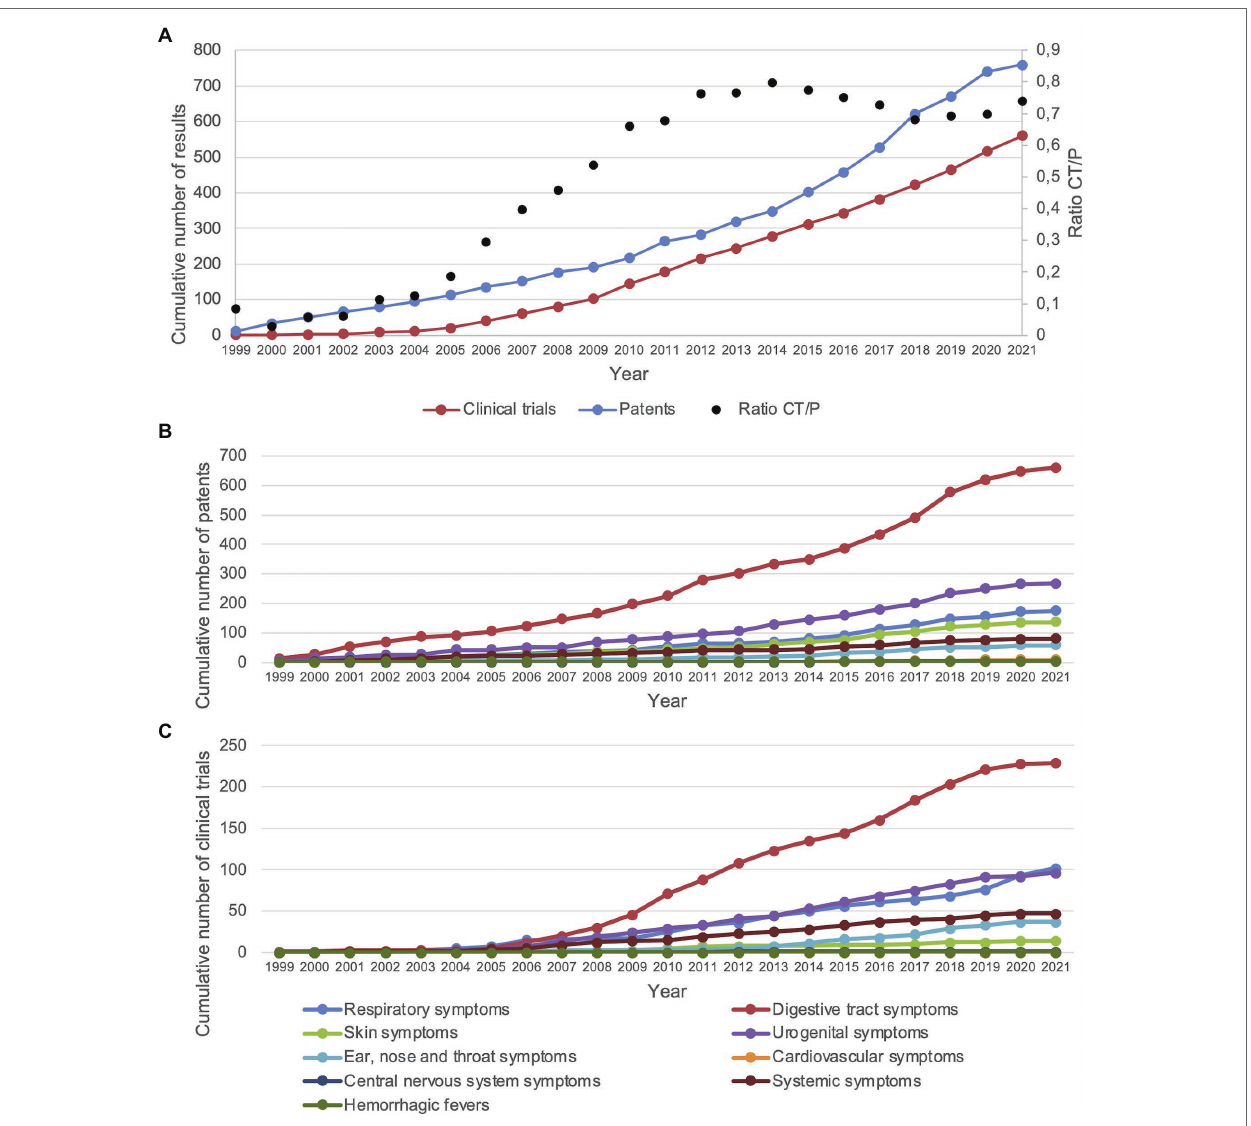
FIGURE 3 | Patents and clinical trials showed an increasing trend since the year 2000. (A) CT/P = clinical trials/patents. Displayed are the cumulative number of patents and clinical trials as well as the ratio of clinical trials and patents. (B) Cumulative number of patents for each group of clinical symptoms of infectious diseases. (C) Cumulative number of clinical trials for each group of clinical symptoms of infectious diseases. Cardiovascular and central nervous system symptoms are obscured due to overlap with hemorrhagic fevers. The years 2020 and 2021 may not be complete due to the 18-month patent application period and COVID- 19-related